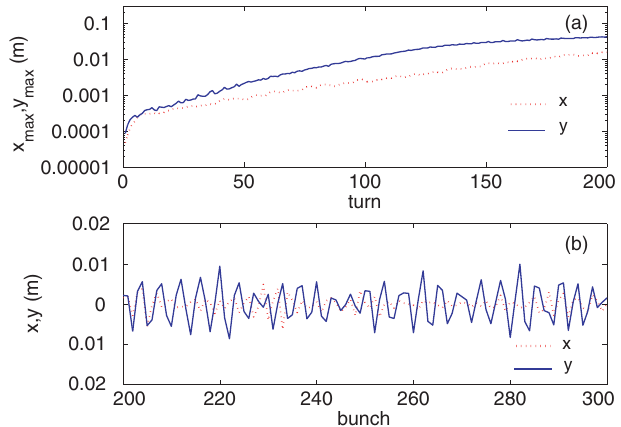
FIG. 15. (Color) Growth of the horizontal ( x : solid curve) and vertical ( y : dotted curve) amplitude (a) and bunch oscillation pattern (b) for bunches interacting with electrons in drift